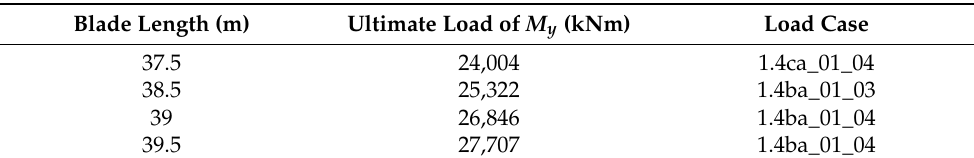
Table 12. Ultimate load M y at tower bottom. (The label of the load case: the first letter refers to wind speed, b for 11.5 m/s and c for 13.5 m/s; the second letter refers to yaw error and “a” for − 8 deg; the middle number refers to wind direction change and 01 for positive direction change; the last number refers to starting azimuth angle, 03 for 60 deg and 04 for 90 deg). Blade Length (m) Ultimate Load of M y (kNm) Load Case